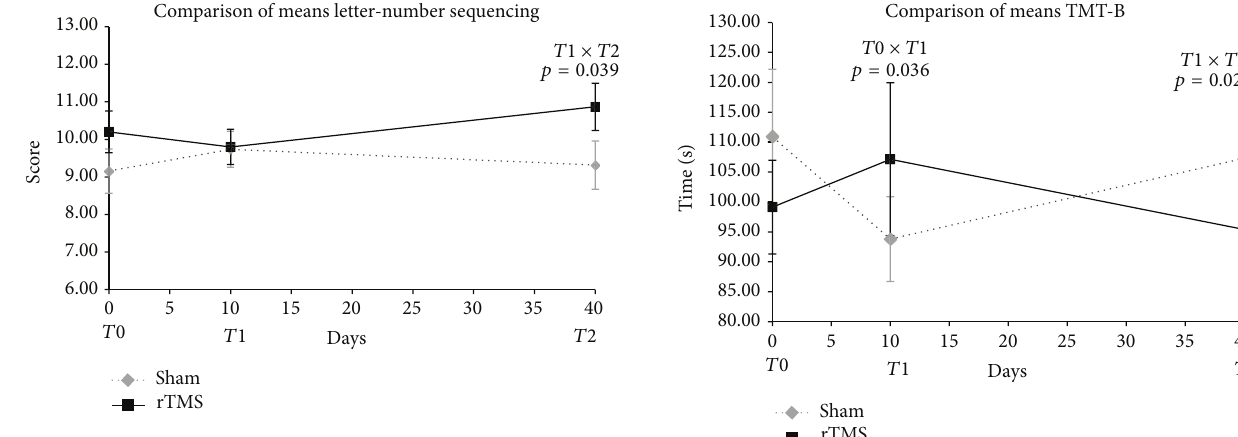
Figure 4: Comparison of letter-number sequencing means scores in T0, T1, and T2. Two-way ANOVA for repeated measures. Timing of procedures: T0: baseline cognitive assessment and 1st rTMS; T1: 10th rTMS session and 2nd cognitive assessment; T2: 30 days after T1 and 3rd cognitive assessment. Student’s 𝑡 -test for comparison of rTMS versus sham basal means, 𝑝 = 0.211 .